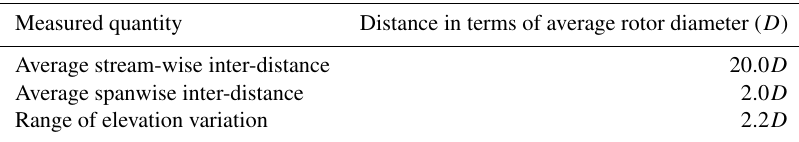
Table A1. This table lists several key attributes that characterize the nature of the terrain and turbine layout of the observed wind farm discussed in Sect. 4.2. Distance values are reported relative to the average turbine rotor diameter ( D ). Spanwise and stream-wise directions are defined to be perpendicular and parallel to the average wind direction during the wind farm,